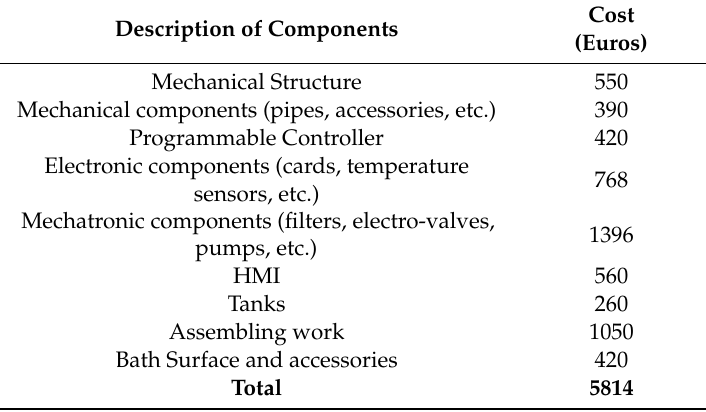
Table 3. Cost of prototype developed (1st